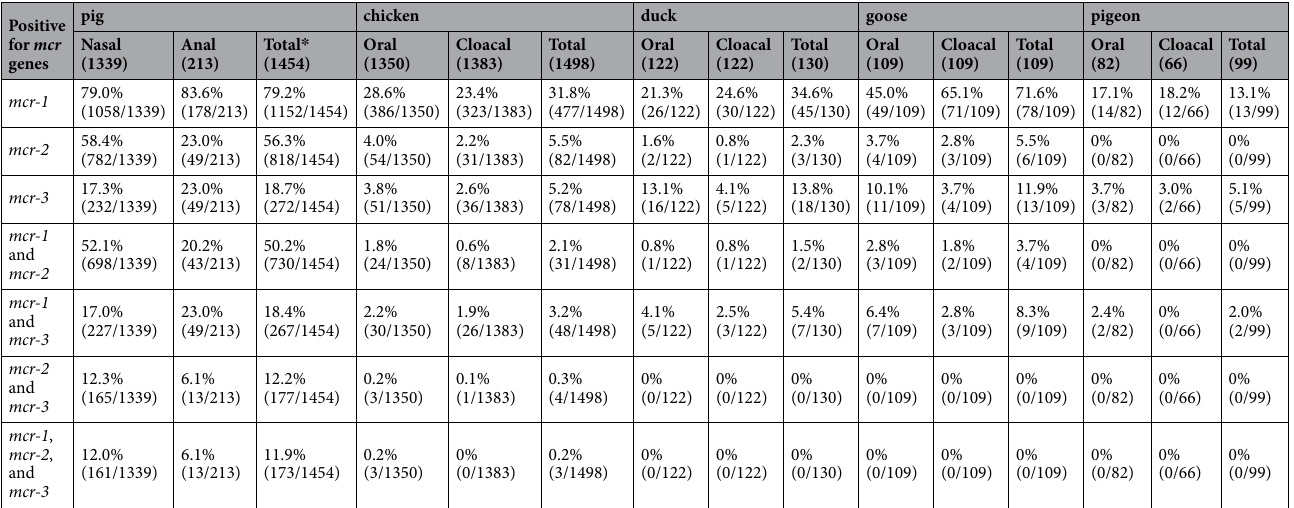
Table 2. Co-occurrence of mcr genes in swabs from pigs and poultry in this study. * Total means the total number of the assayed animals. Under the column of Total, when one of the Nasal/Oral and Anal/cloacal swabs was positive, this animal was considered to be